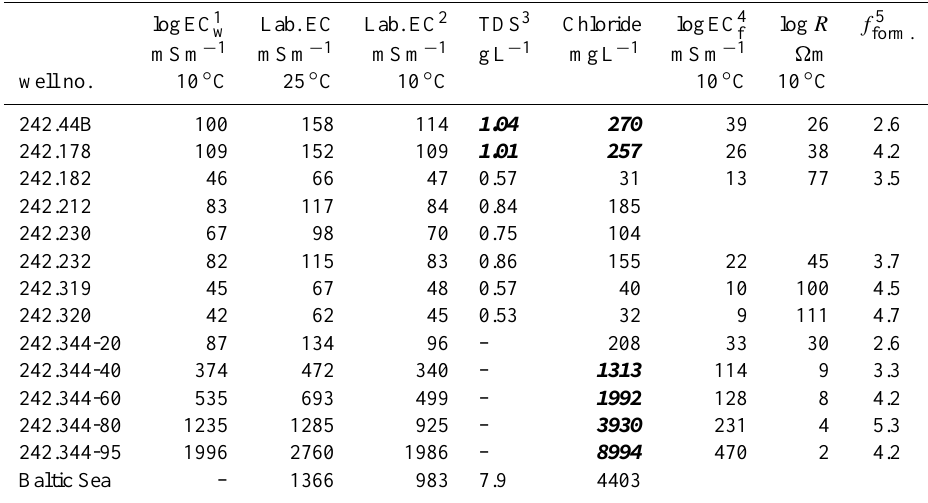
log R f 5 f form.